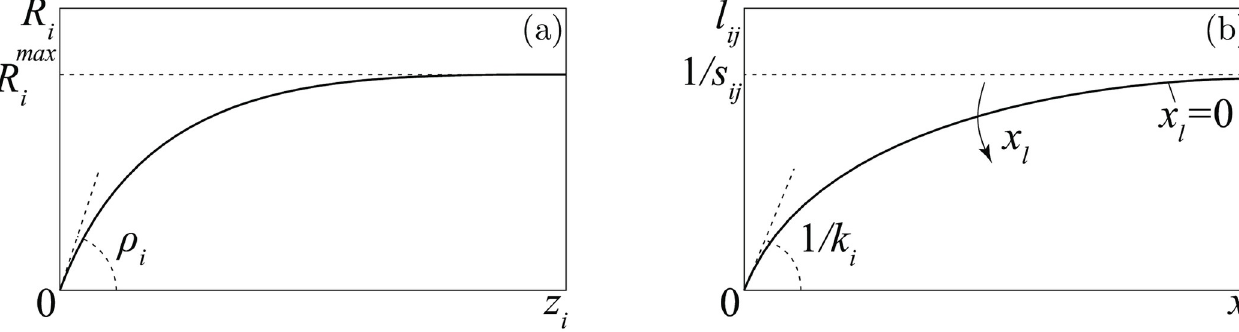
PLOS ONE | https://doi.org/10.1371/journal.pone.0264418 March 4,